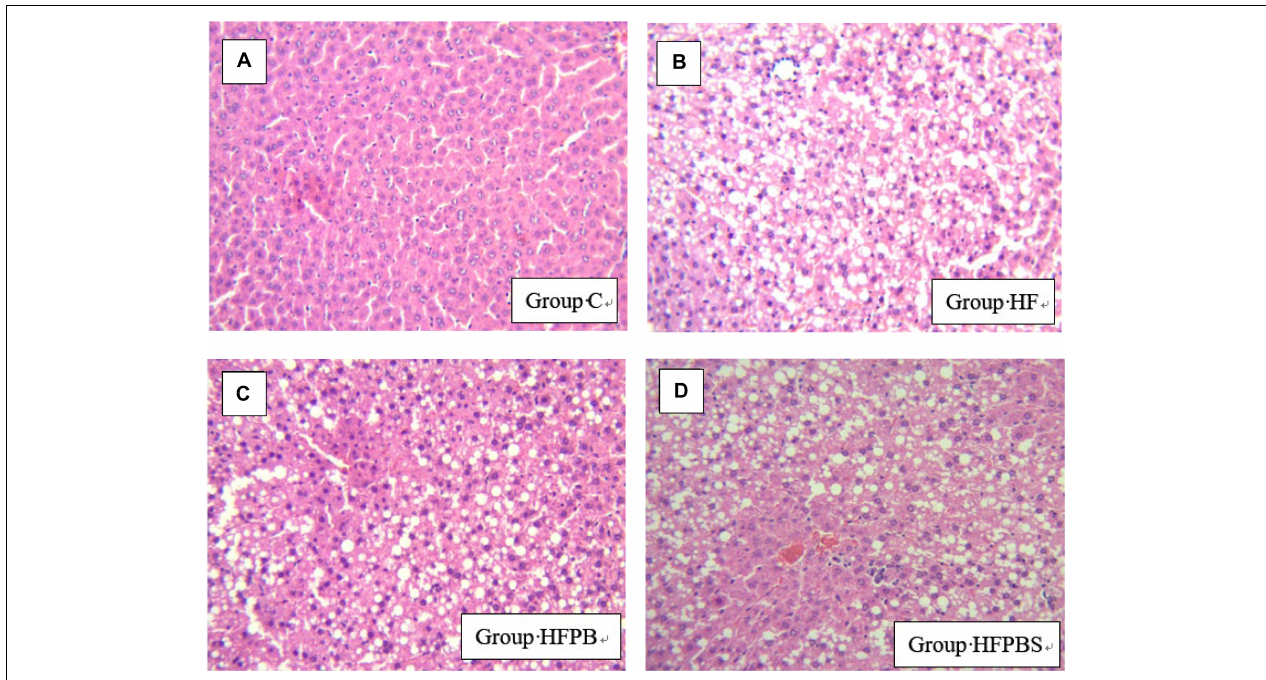
FIGURE 1 | Histopathological examination of liver tissue showing damage and arrangement of hepatocytes and fat vacuoles (100 × magnification) ( n = 10). (A) Tissue from the C group showing a normal liver with no lipid deposits. (B) Liver tissue from the HF group showing the presence of steatosis. (C) Tissue from the HFPB group showing the presence of steatosis. (D) Cells from the HFPBS group containing many large fat